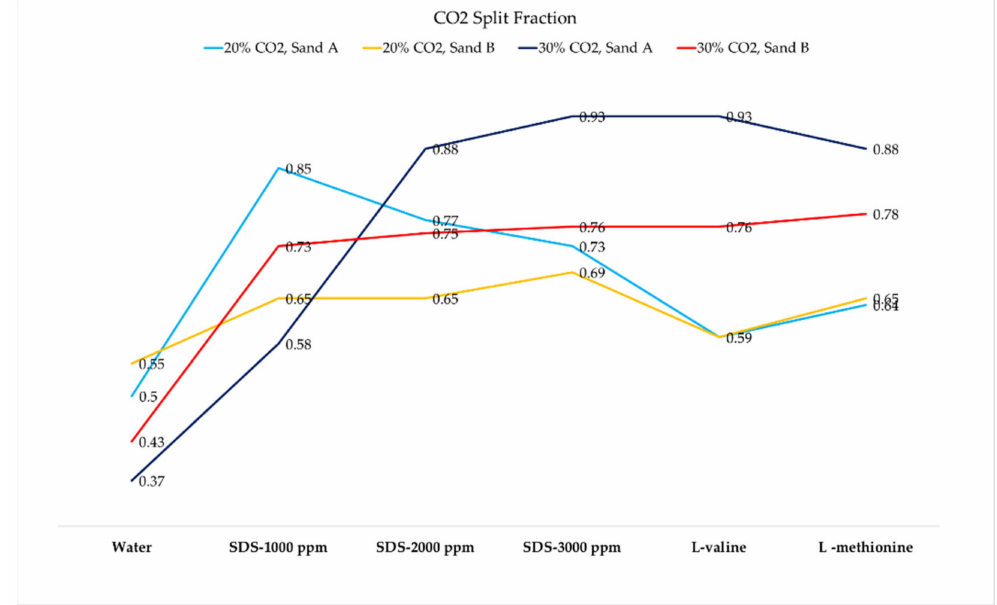
Figure 13. CO 2 split fraction analysis due to change in the sand (Sand A and Sand B) for di ff erent CO 2 concentrations in feed gas (Gas A and Gas B) in the presence of di ff erent chemicals from Table